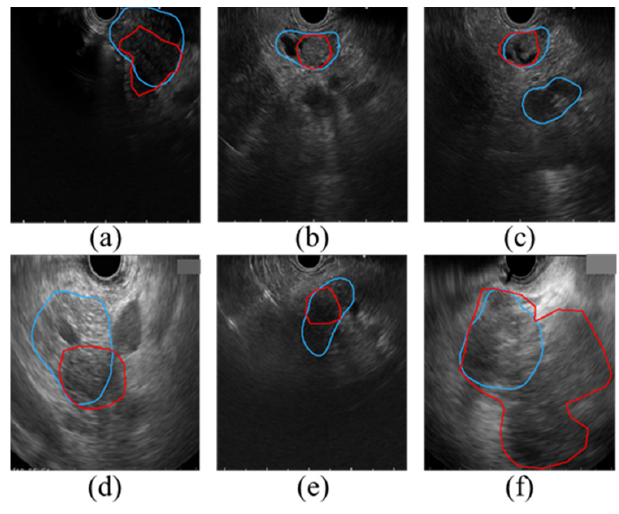
Figure 9. Cases where the IoU is less than 0.5 in the segmentation using DAF-Net (Red line: GT boundary, blue line: predicted boundary). ( a ) EUS probe not properly contacted with the tissue, ( b ) cancer along with pancreatic duct dilation, ( c ) similar texture of the surrounding blood vessels and organs, ( d ) parenchymal atrophy by chronic pancreatitis ( e ) intratumoral necrosis associated with chronic pancreatitis, and ( f ) large tumor size.